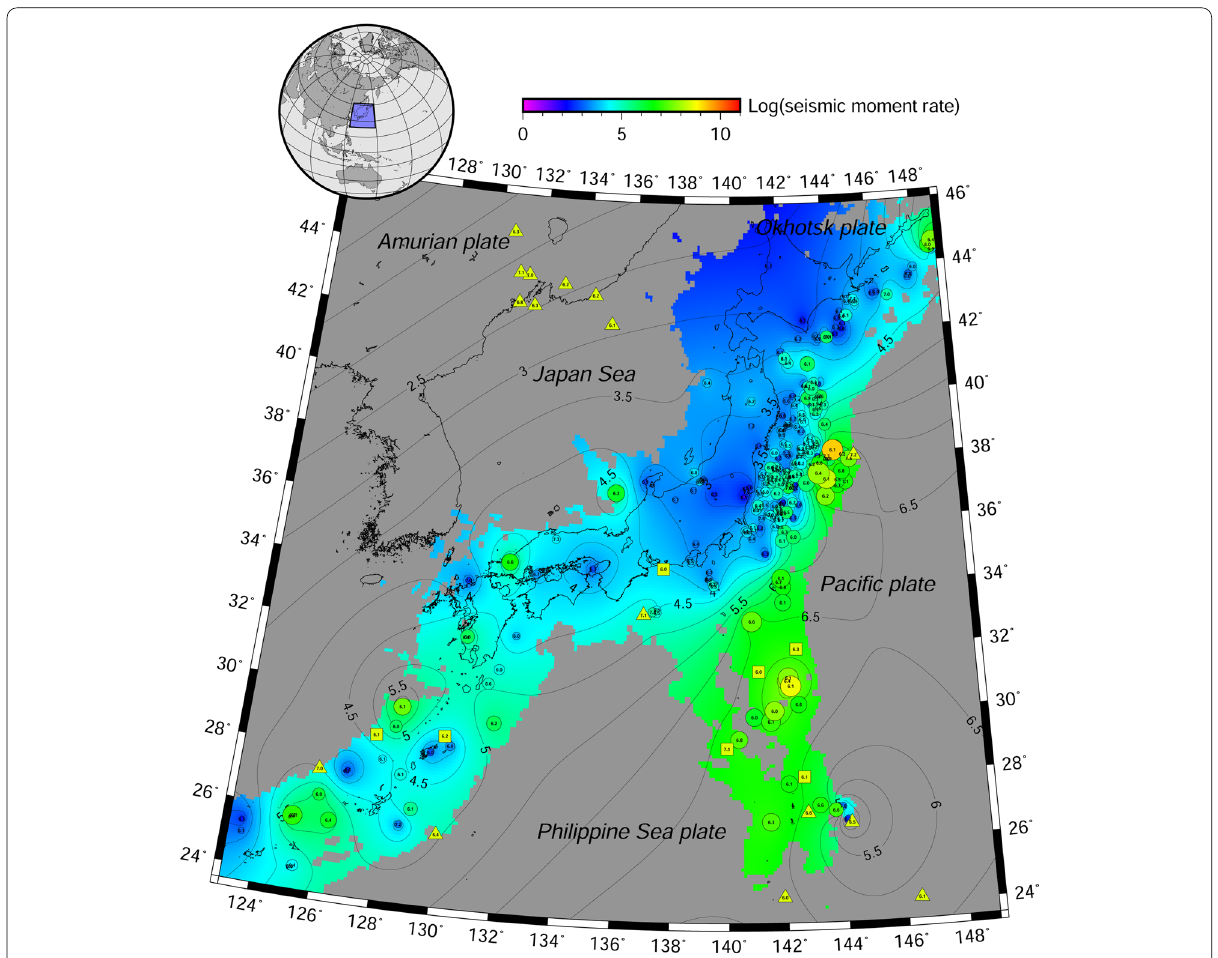
Fig. 9 Distribution of the logarithm of the seismic moment rate (log c ) obtained by the MMSI method and compared with the hypocenters of recorded M5 earthquakes from 1997 to 2015 at depths shallower than 60 km using a threshold of 10,000 events for each seismically dense sphere. + The color indicates the seismic moment rate (log c ) value in and around Japan in this study. The squares and triangles indicate that the seismically dense spheres are unable to calculate the MMSI due to insufficient foreshocks before (squares) or after (triangles) December 31, 1998, while the circles indicate the seismically dense spheres with sufficient foreshocks to calculate the MMSI. The number inside the squares, triangles, and circles indicates the magnitude of M5 earthquakes. The size of the squares and triangles is fixed. The radii of the circles indicate the ratio value of the + smallest seismic moment rate of the foreshocks versus the seismic moment rate of the M5 mainshock. Small radii of circles indicate that the M5 + + earthquake (usually landward) occurred immediately after a large seismic interval or the foreshocks are associated with a small seismic